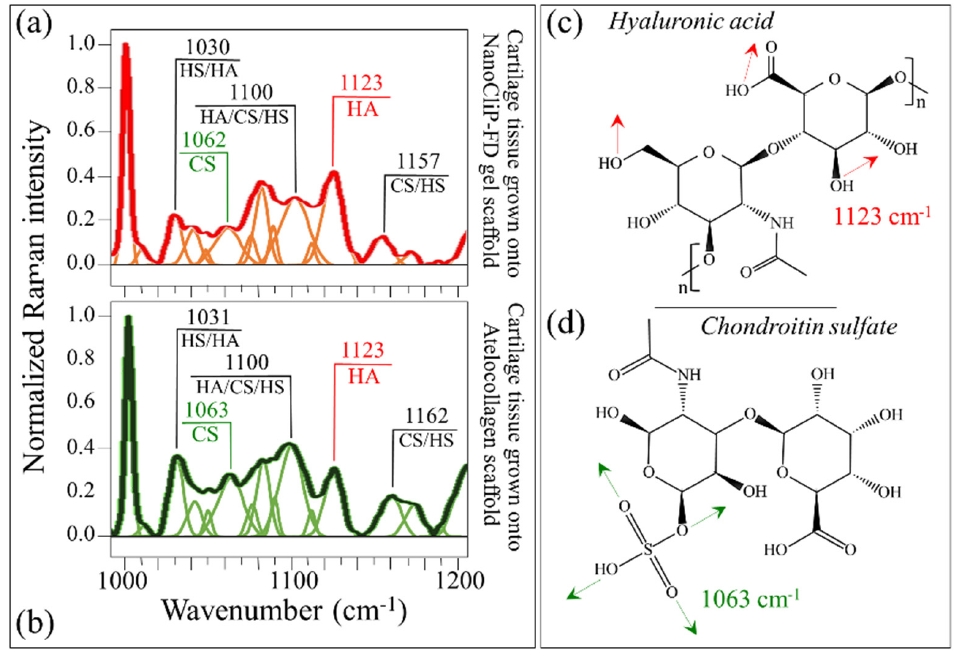
Figure 5. The Raman spectral zone between 1000 and 1200 cm − 1 (characteristic of GAGs) is deconvo- luted into sub-bands related to CS, HA, and HS (cf. labels): cartilage grown onto ( a ) NanoCliP-FD gel and ( b ) atelocollagen scaffolds. Structure and fingerprint bands for HA (bending vibrations of C-OH groups) and CS (O-S-O 3– symmetric stretching) are given in ( c , d ), respectively. The amide III spectral zone in the wavenumber interval 1170 to 1500 cm − 1 (cf. labels